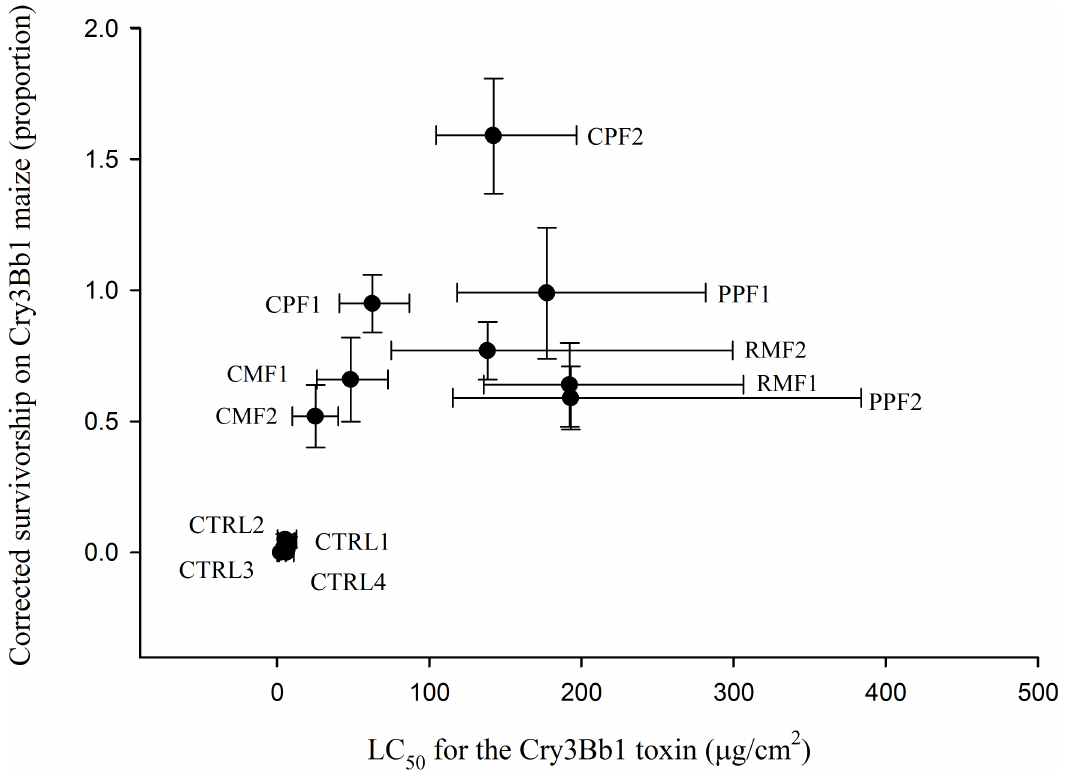
Fig 3. Relations between diet-based and plant-based bioassays for western corn rootworm. Horizontal lines represent 95% fiducial limits on LC 50 values and vertical lines represent the standard error of mean for corrected larval survivorship on Cry3Bb1 maize. Individual points represent samples means. Lables by individual data points represent the follwing: CPF = current problem field, PPF = past problem field, RMF = rotated maize field, CMF = continuous maize field, and CTRL = control population.